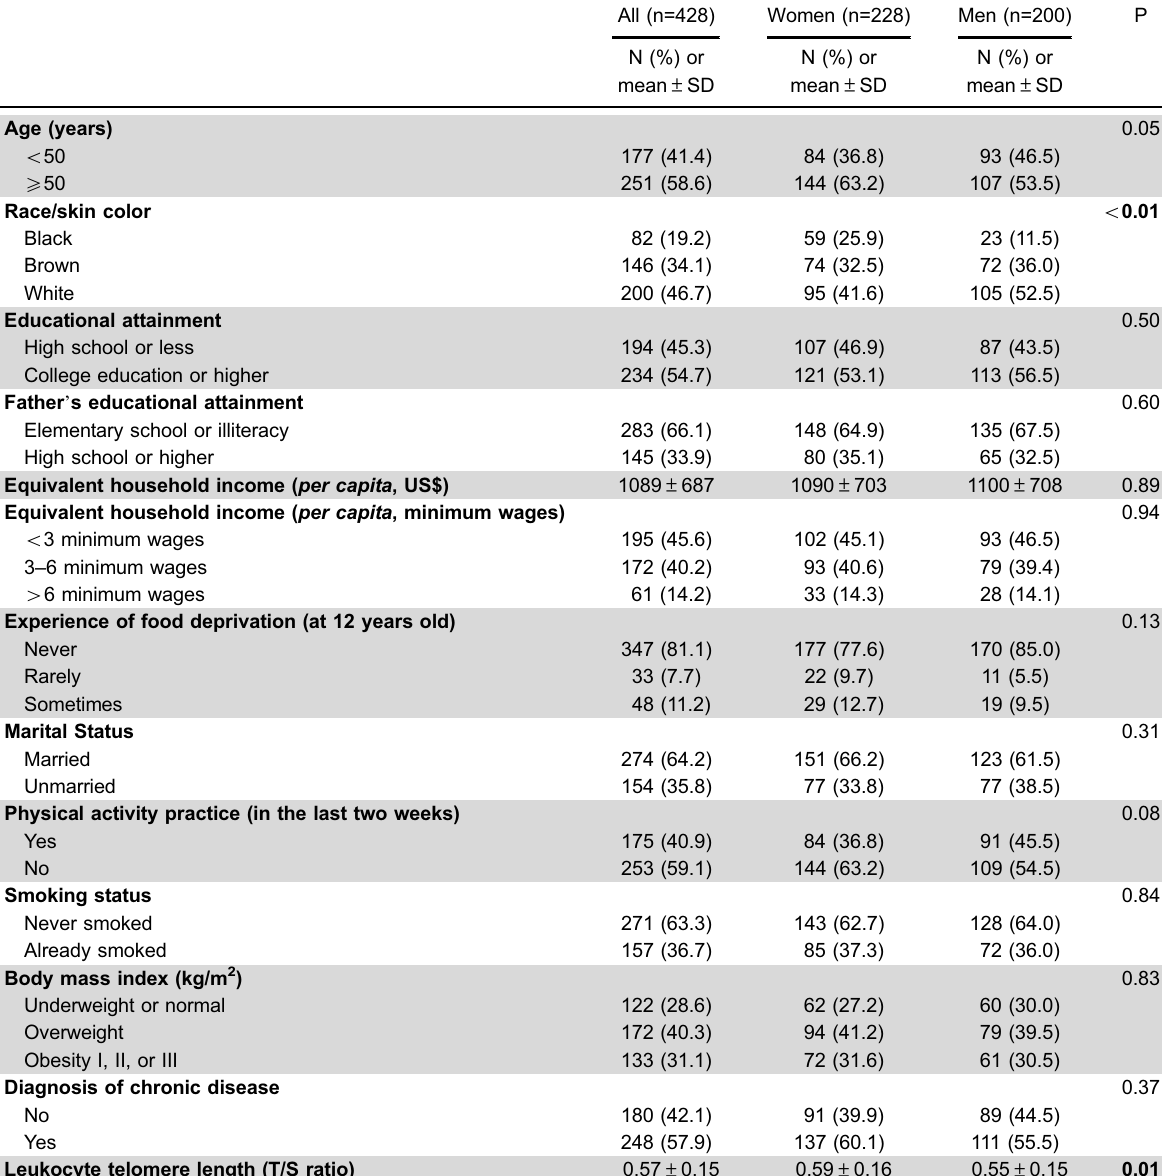
Table 1. General characteristics of the study population, according to sex: Pro-Saúde study – Rio de Janeiro, Brazil, 2012 –